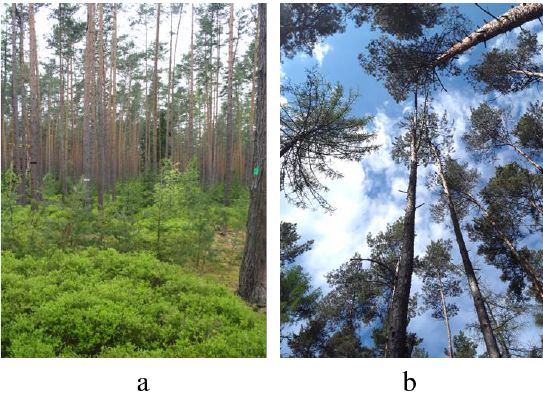
Figure 2: Current (2020) in situ vegetation cover situation of the study area: a) understory vegetation and tree density; b) tree canopy (bottom-up).